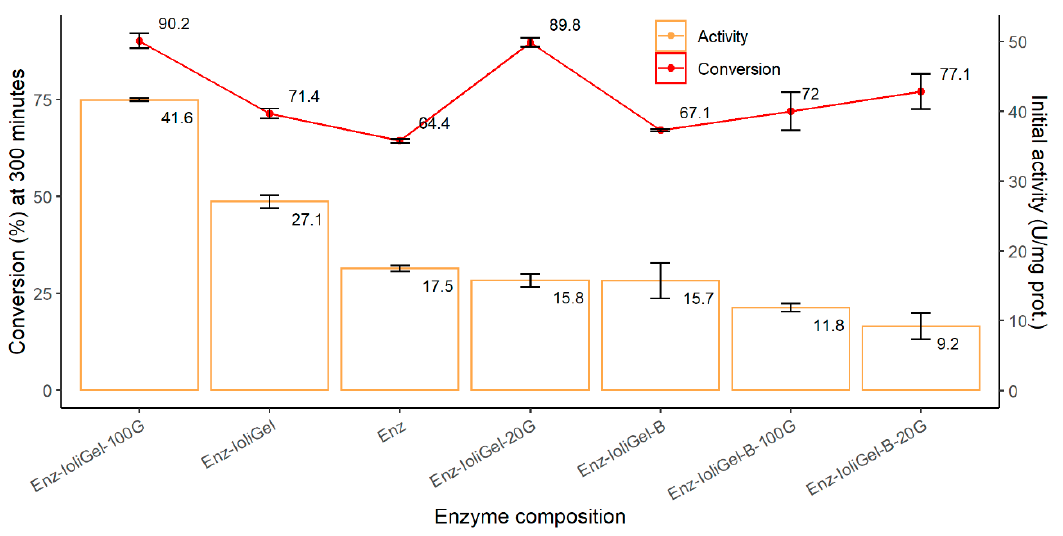
Figure 5. Activity and conversion exhibited by CaLB during butyl butyrate synthesis using different immobilized CaLB (ionogel) and free enzyme at 70 °C.